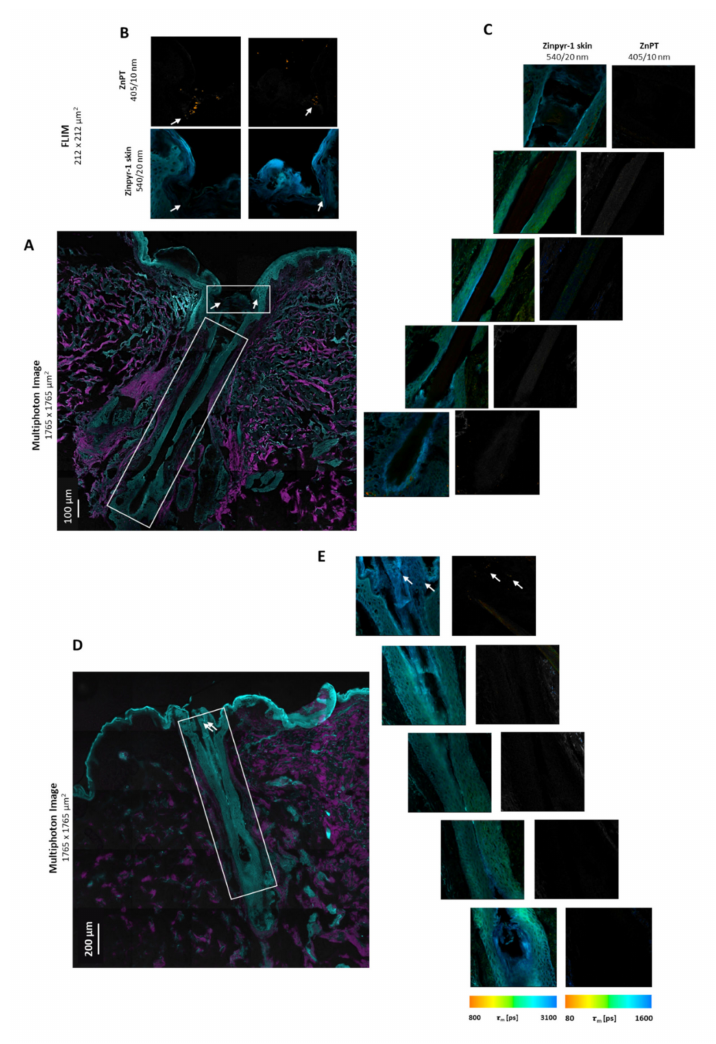
Figure 4. Follicular delivery from commercial product H&S : ( A ) MPM image of H&S (ZnPT 2% w / v ) applied with no massage and ( B ) the corresponding FLIM images along the length of the follicle. ( C ) MPM image of DHS applied with 2 min massage and ( D ) the corresponding FLIM images along the length of the follicle. For MPM images ( A , C ), two excitation wavelengths were used: two-photon excitation at 800 nm with emission collected at 395–420 nm (pink) and one-photon excitation at 488 nm with emission collected at 520–560 nm (blue). Scale bar = 200 µ m ( A ) and 100 µ m ( C ). The parameters for the FLIM images ( B , D , E ) were: two-photon excitation at 740 nm with emission collected using a 405/10 nm bandpass filter for ZnPT and 540/20 nm bandpass filter for Zinpyr-1. FLIM images are pseudo-coloured to the average time-weighted lifetime τ m [ps]. Arrows indicate position of deposited ZnPT